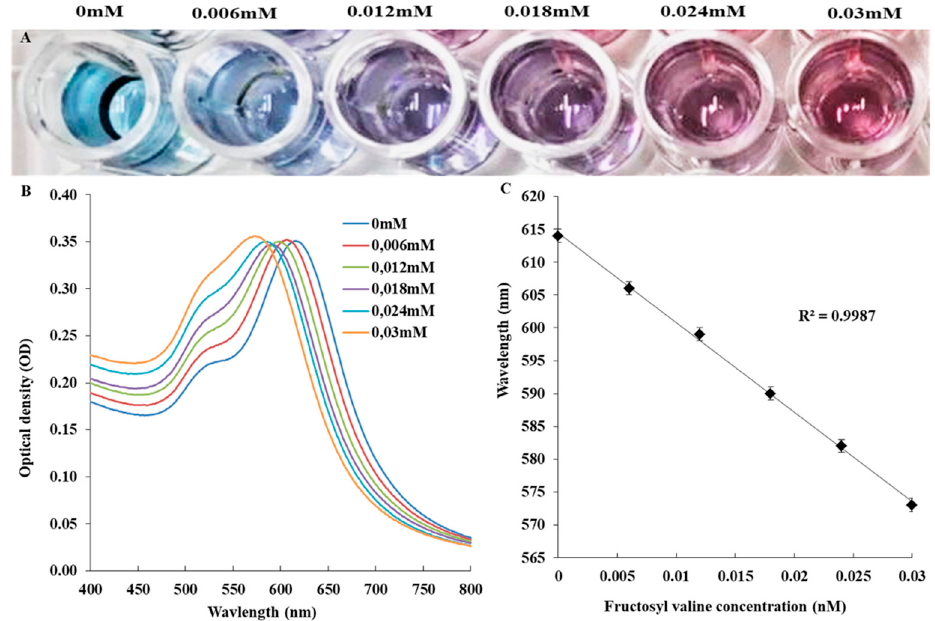
Figure 2. Feasibility assay. ( A ) Photograph showing the colour change of the nanostar with increased fructosyl valine concentration. ( B ) The corresponding UV-vis spectra and ( C ) scatter plot of the wavelength at ODmax and fructosyl valine concentration with linear regression fit.